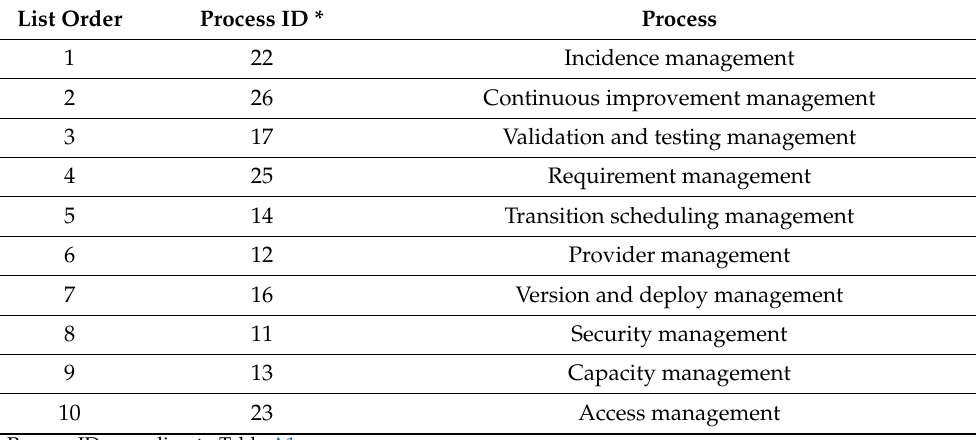
Table 3. Proposal of ordered list of ITIL processes for a representative tourism